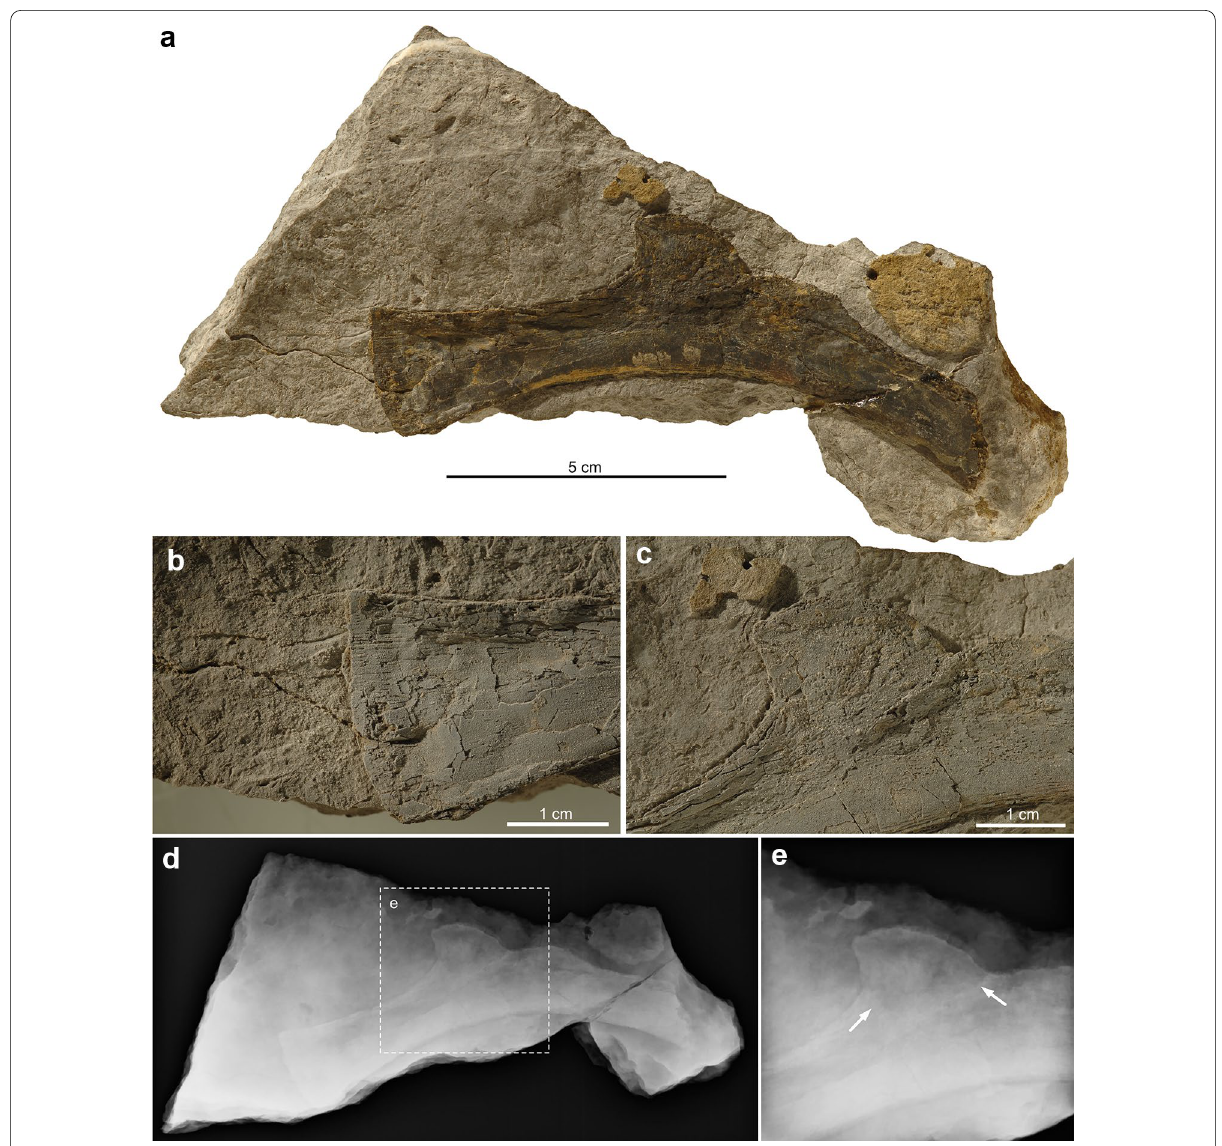
Fig. 2 PIMUZ A/III 5166, a large saurosphargid thoracic rib with a low uncinate process and sub‑triangular osteoderm. Images in b and c show specimen coated in ammonium chloride to enhance surface structures. a Complete specimen on slab of sediment. b Close‑up of the slightly expanded holocephalous rib head. Note striation of the bone close to the articular surface. c Close‑up of the uncinate process and the osteoderm, the latter exhibiting a slightly pitted surface sculpturing oriented differently than that of the rib. d , e Radiographic image of complete specimen ( d ) and close‑up ( e ) of the osteoderm. The boundary of rib and osteoderm is indicated by white arrows